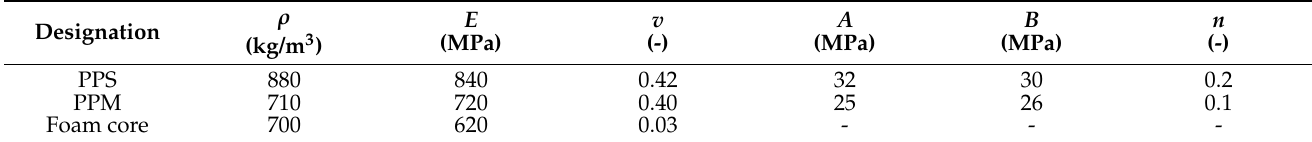
Table 2. Material properties of